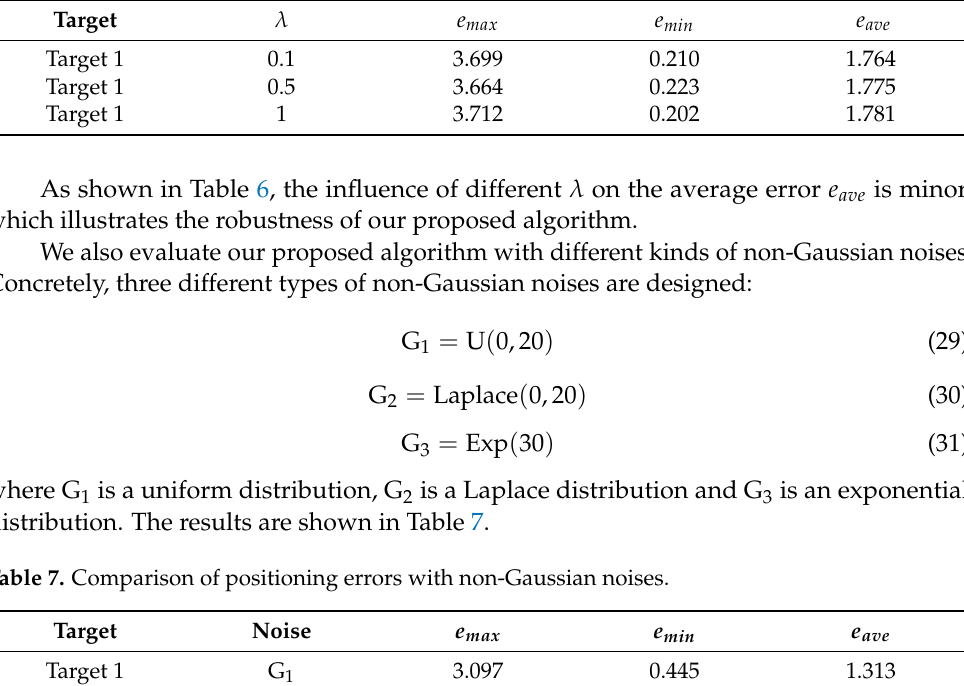
Table 6. Comparison of positioning errors with different Gaussian noise of target 1’s trajectory.